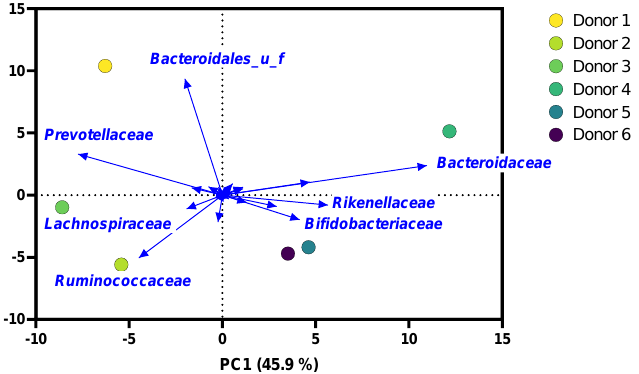
Figure 1. Distinct interpersonal differences in microbial composition were observed for the 6 human adults . Principal component analysis (PCA) summarizing microbial composition at family level. The PCA was based on centered abundances (%).